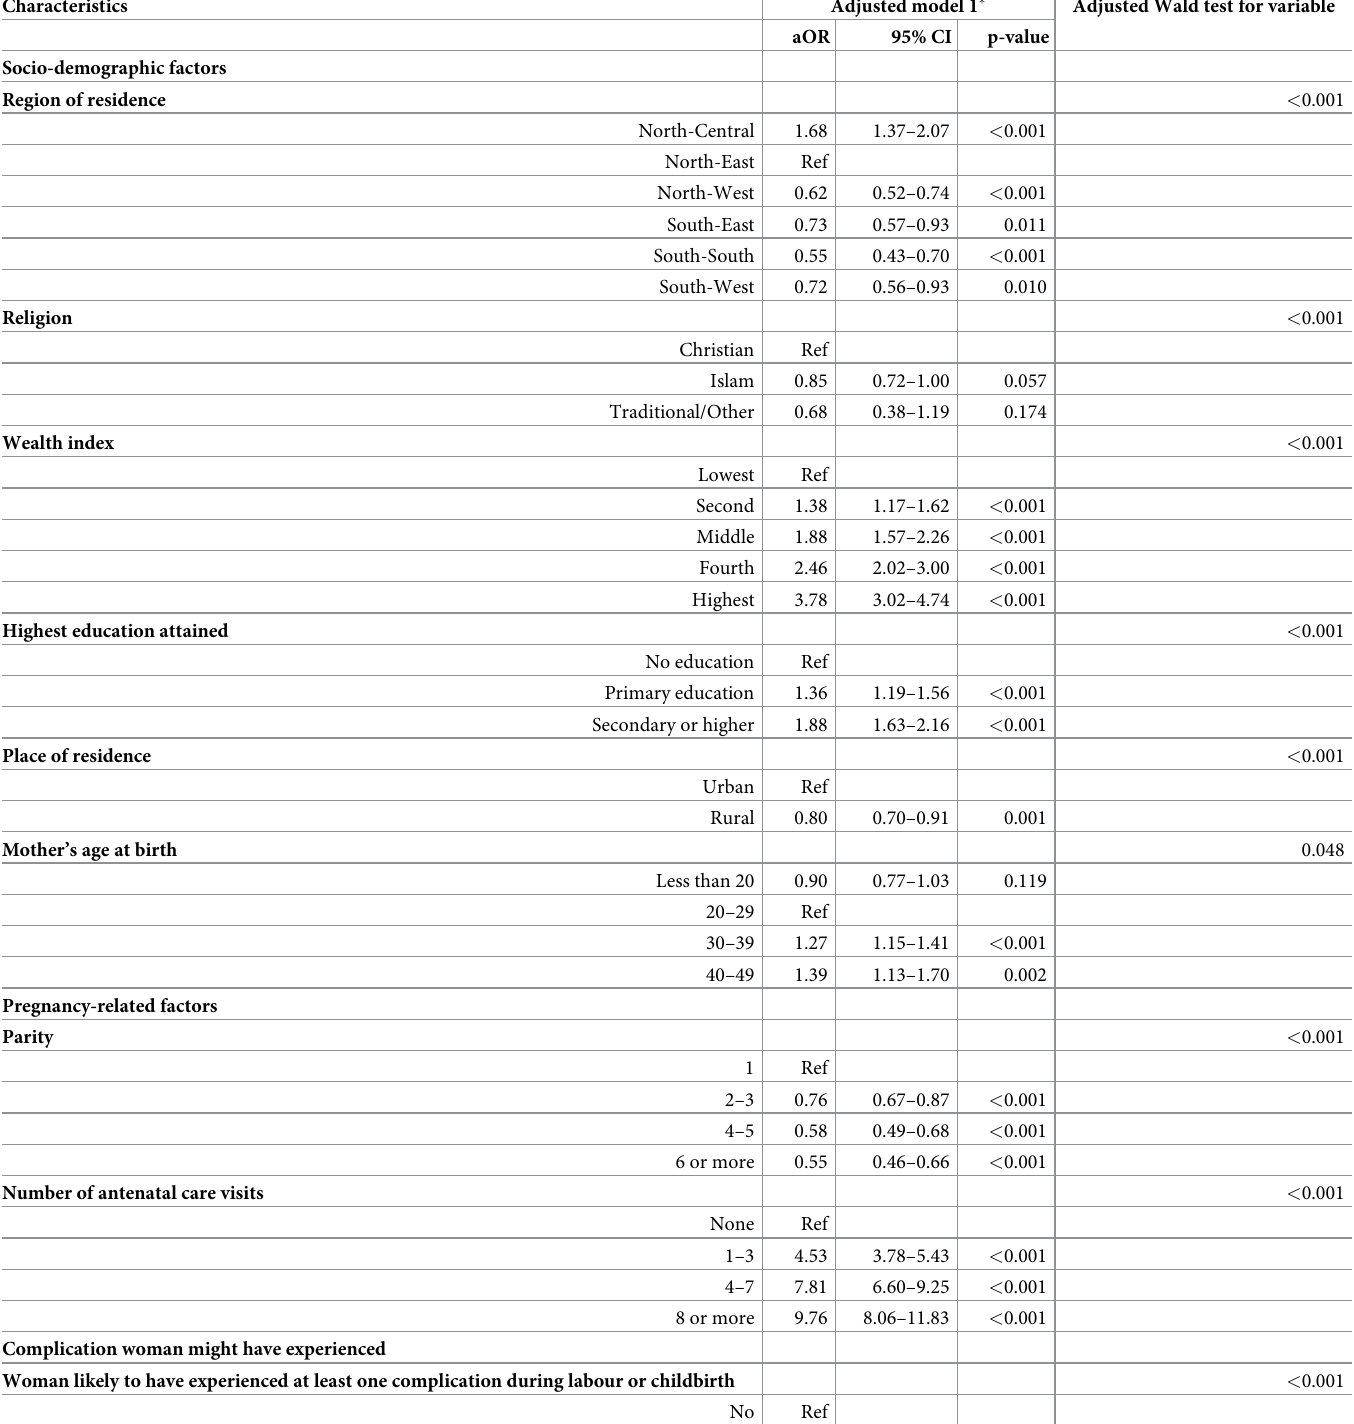
Table 3. Logistic regression model for use of motorised transport to place of childbirth as an outcome in the 2018 NDHS (N = 21,823).